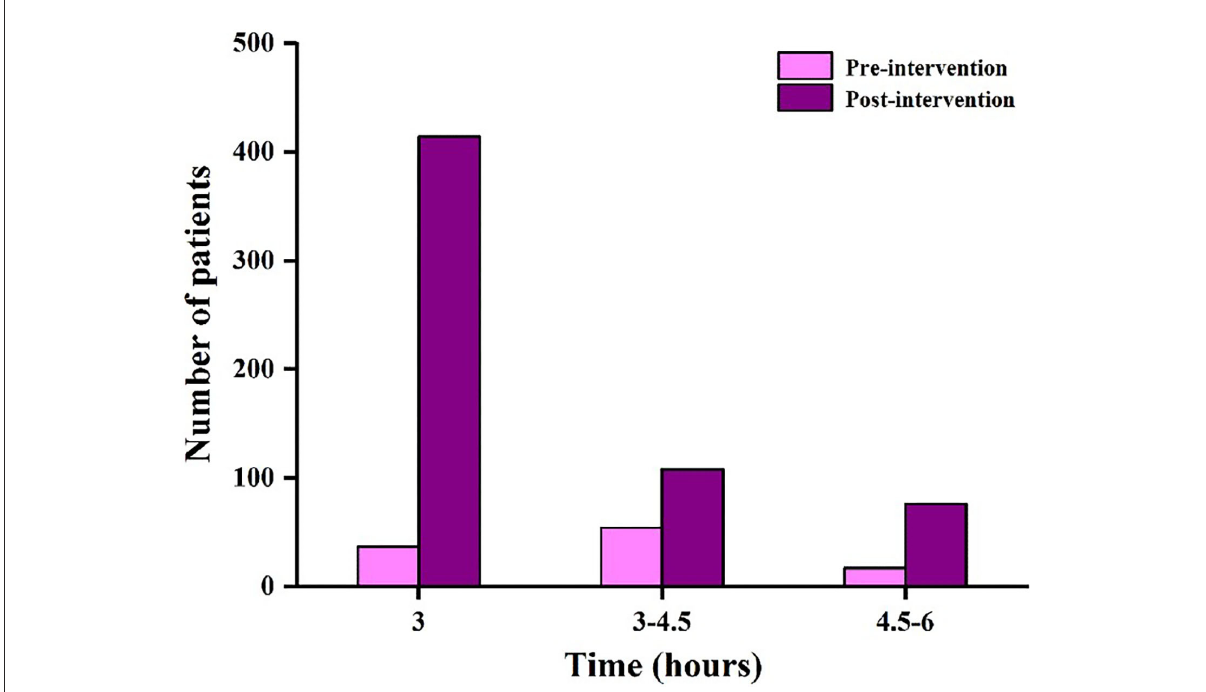
FIGURE2 The number of AIS patients with intravenous thrombolysis in the pre-intervention and post-intervention groups at different time periods (3, 3–4.5, and 4.5–6h).